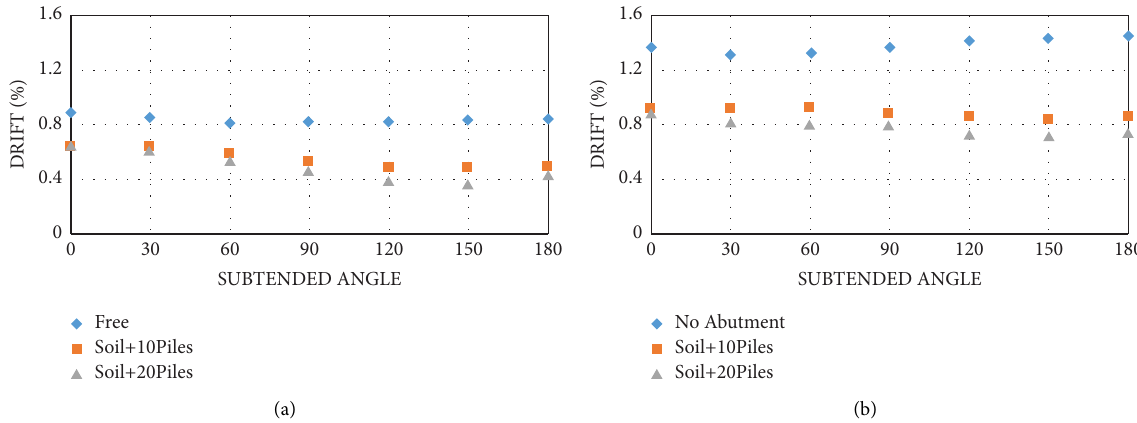
Figure 19: Drift demands of side columns in all bridge confgurations in the radial direction using GMs compatible to (a) DBE and (b) MCE response